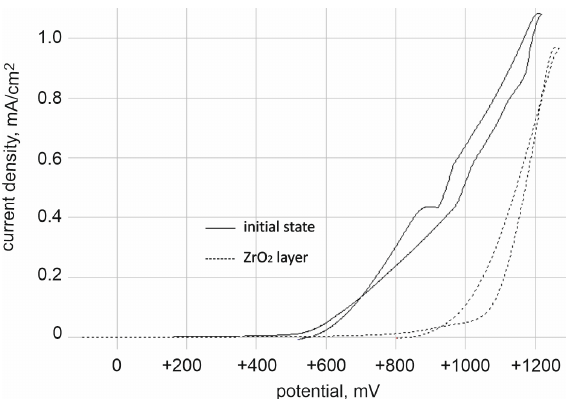
Figure 4. Example of the polarization curves for the sample in the initial state and coated ZrO 2 .